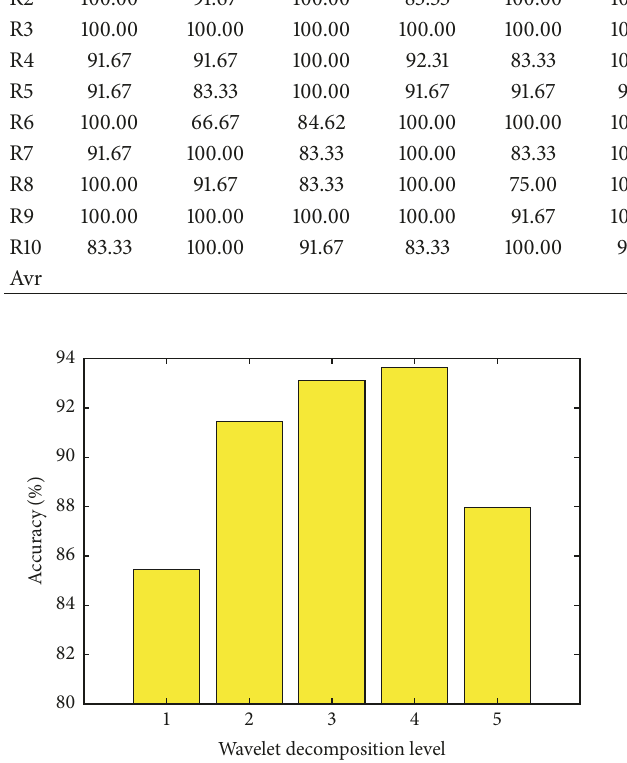
Figure 8: Choosing the optimal wavelet decomposition level.